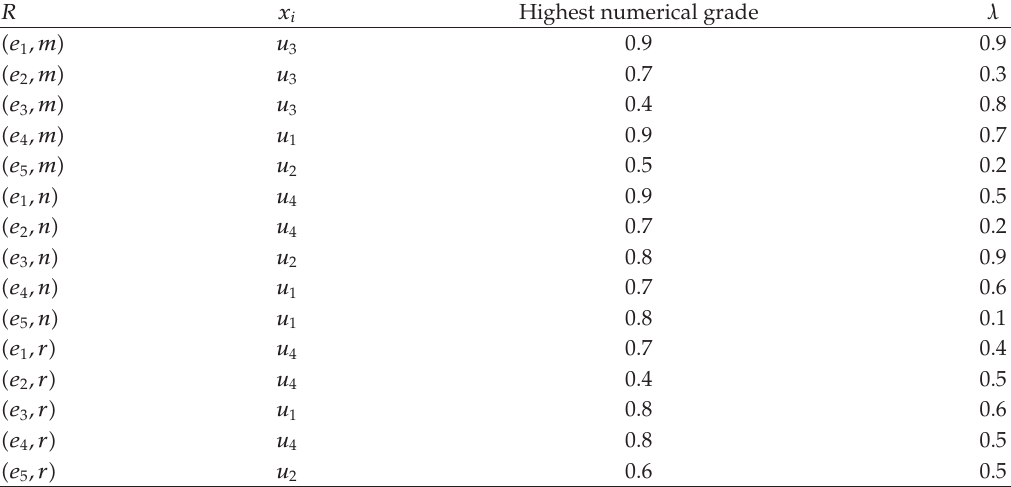
Table 4: Grade table of disagree-generalized fuzzy soft expert